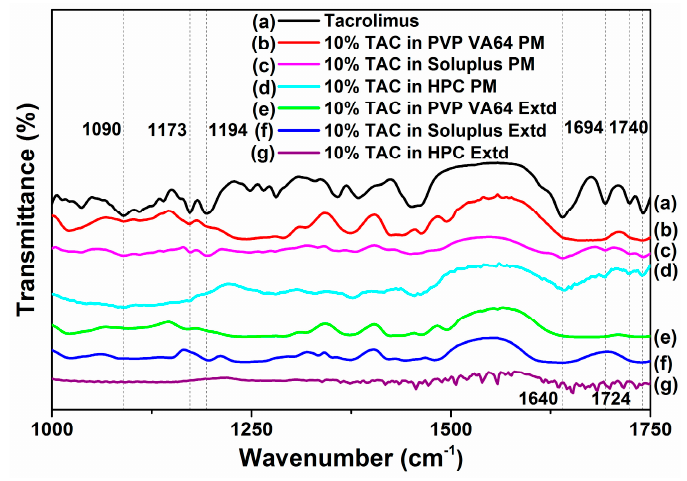
Figure 6. FTIR spectra of TAC and solid dispersion formulations in PVP VA64, Soluplus and HPC.